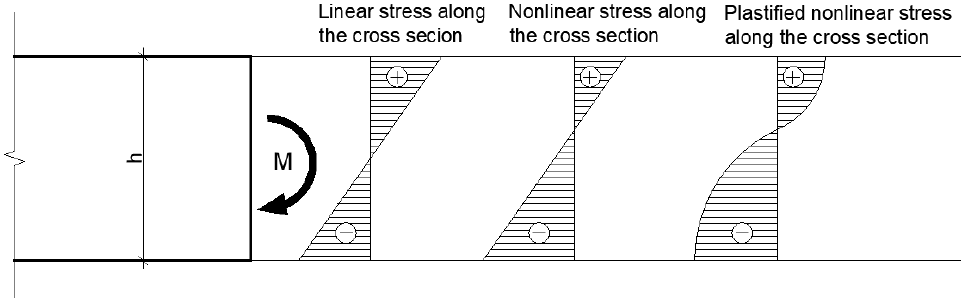
Figure 17. Stress redistribution over cross-section in box specimen model–comparison between linear and no-linear stage.